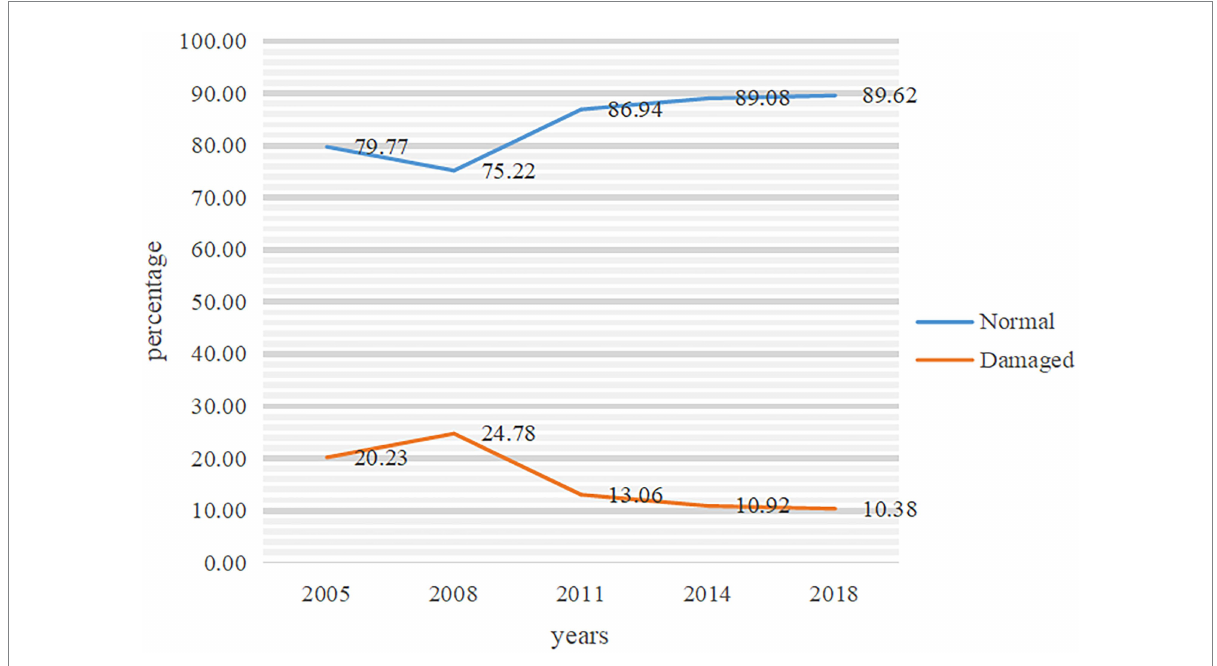
FIGURE 1 Basic information about cognitive function in the elderly.